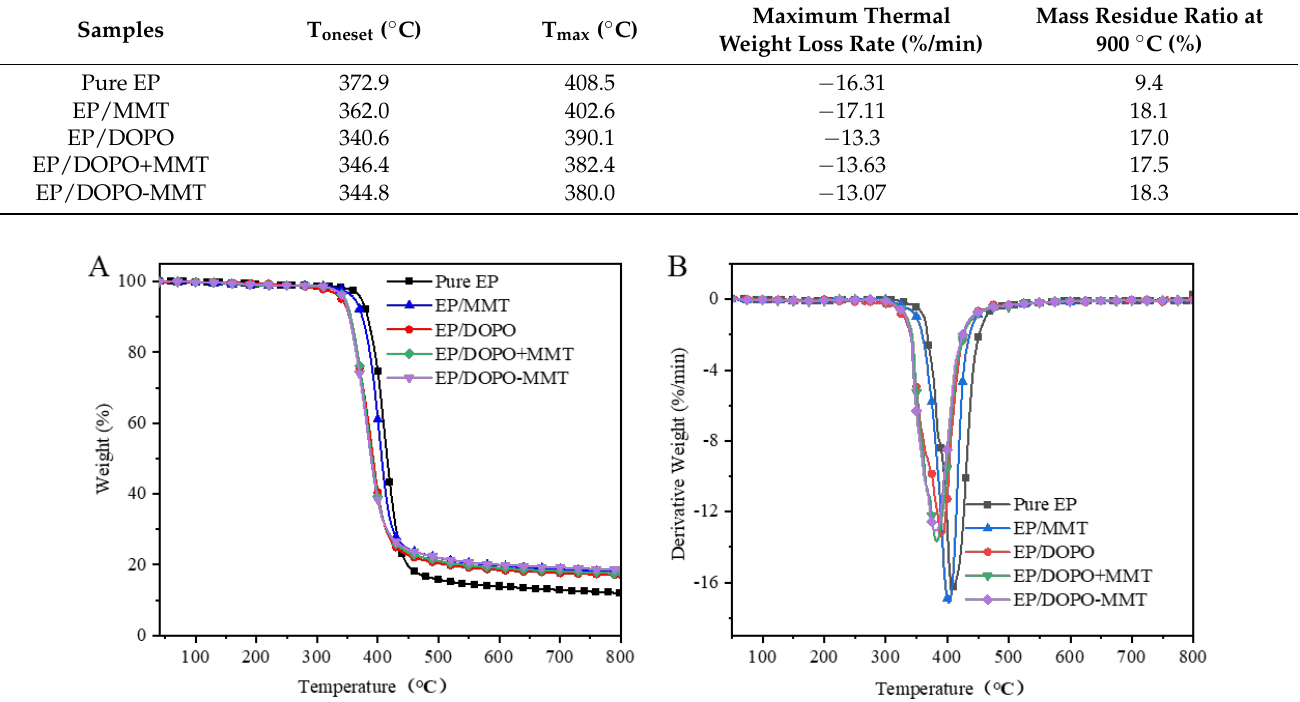
Table 2. Thermogravimetric data of Eps in N 2 .